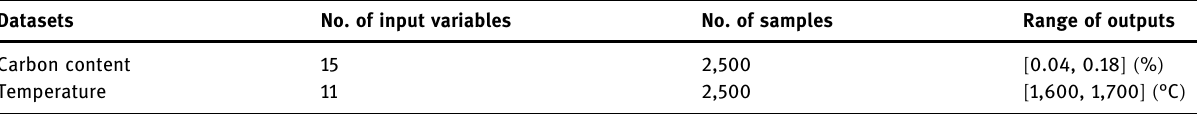
Table 2: Details of the datasets of the BOF steelmaking production process Datasets